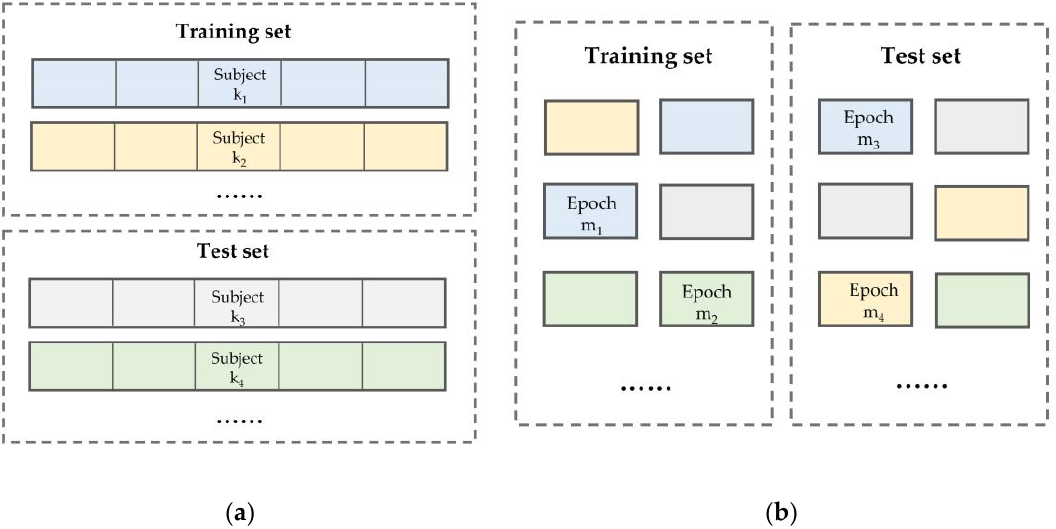
Figure 3. Two training and testing set partitioning methods: ( a ) subject-wise; ( b ) epoch-wise.